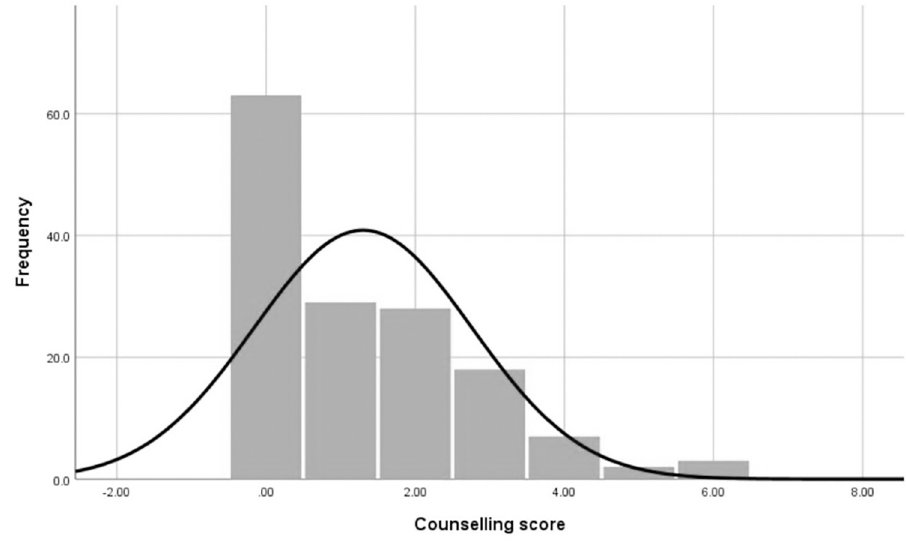
Fig 1. Distribution of counseling score.